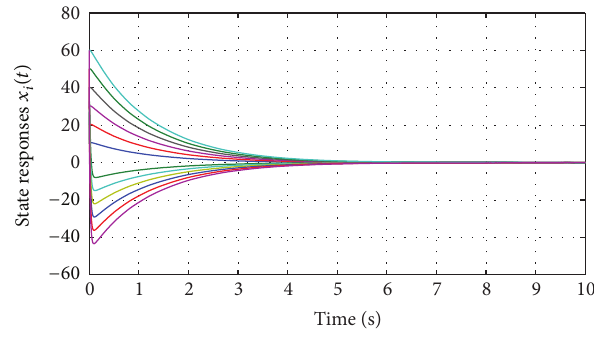
Figure 5: The state trajectories of six agents with topology G